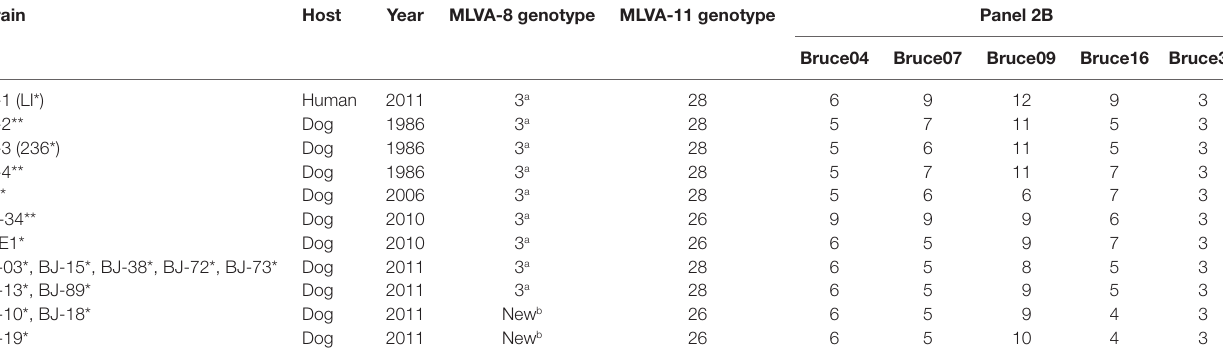
TaBle 2 | MLVA-8 and MLVA-11 genotypes and numbers of tandem-repeat units for panel 2B loci in Brucella canis isolates from Zhejiang province and other regions by MLVA-16. strain